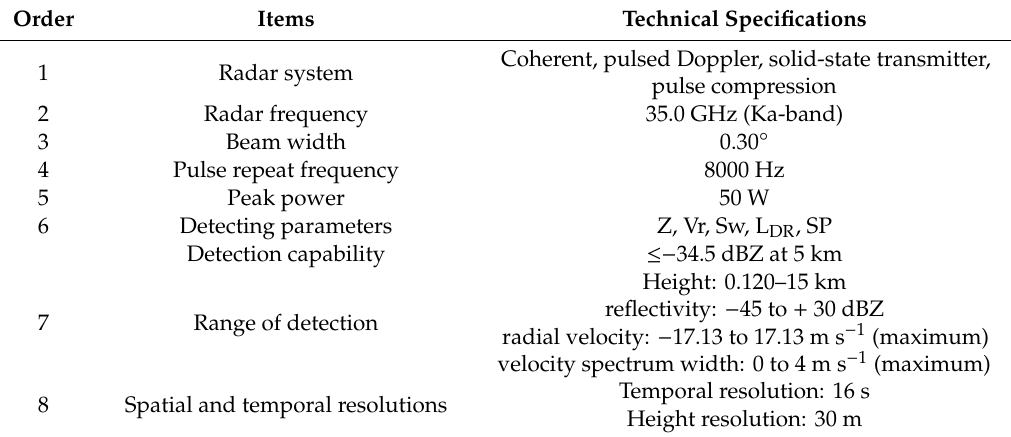
Table 1. Major technical parameters for the Ka-band solid-state transmitter cloud radar.